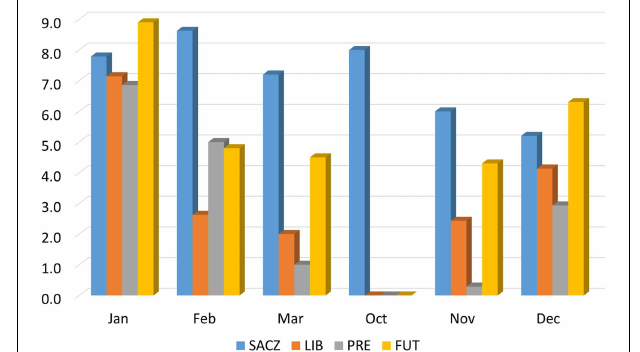
FIGURE 6 | Average duration of actual SACZ events (blue bar) detected by the criterion in the LIB (orange) and PRE series (gray), and events detected in the FUT series (yellow).